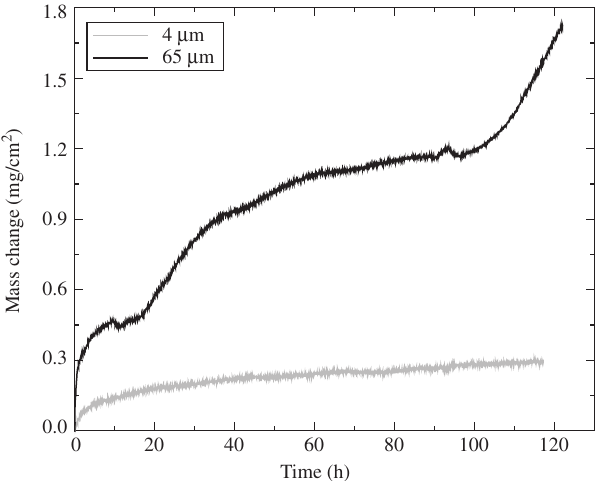
Figure 1. Thermogravimetrically measured oxidation kinetics of TP347 with different grain sizes exposed at 750 °C to laboratory air for 120 hours.